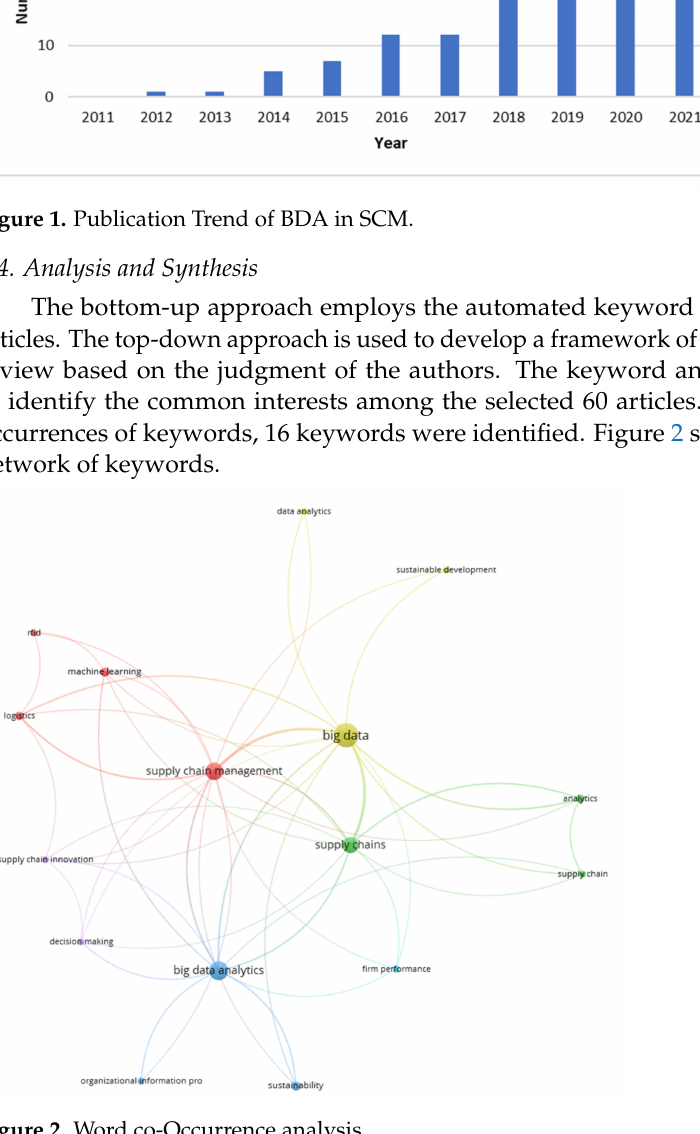
Figure 2. Word co-Occurrence